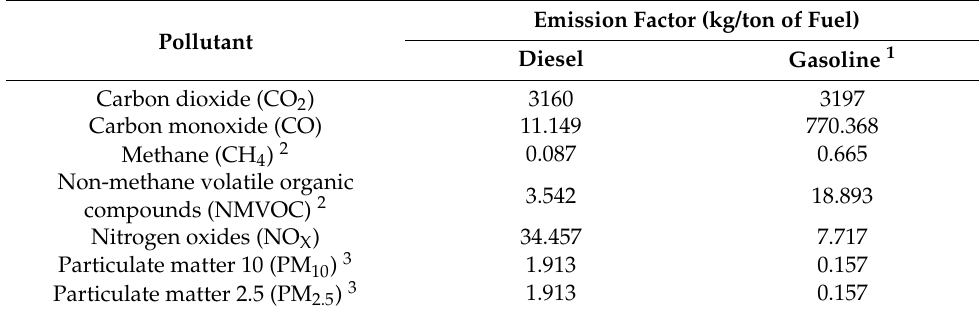
Table 2. Emission factors of gasoline and diesel fuel for agricultural